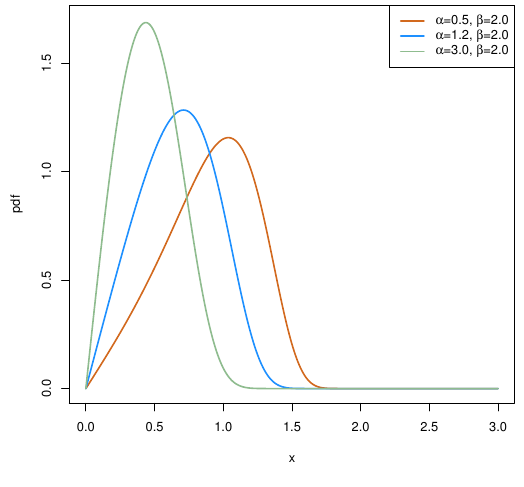
Figure 4. The pdf when β > 1.